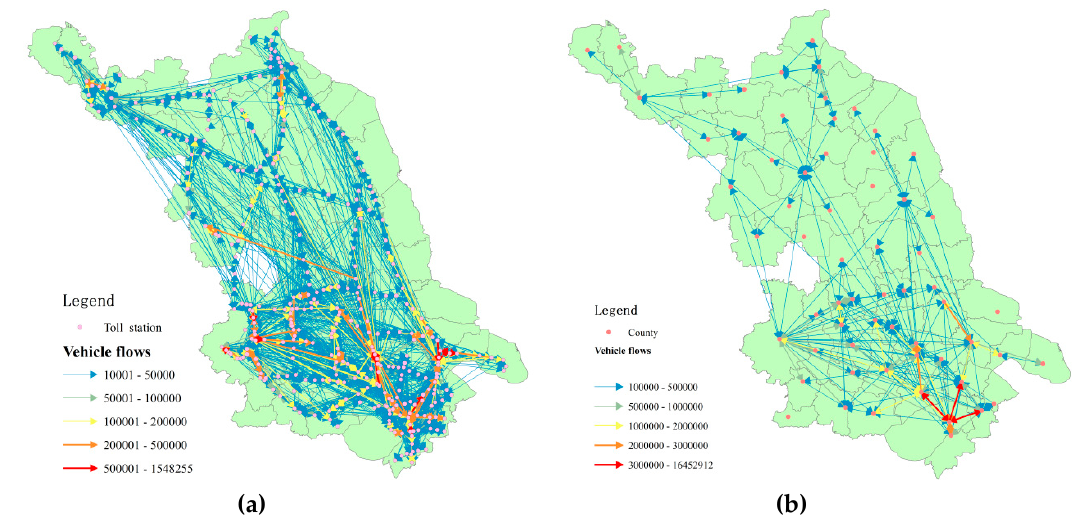
Figure 4. Traffic flows on expressway network. ( a ) Vehicle flows between toll-gates; ( b ) vehicle flows aggregated to county level.